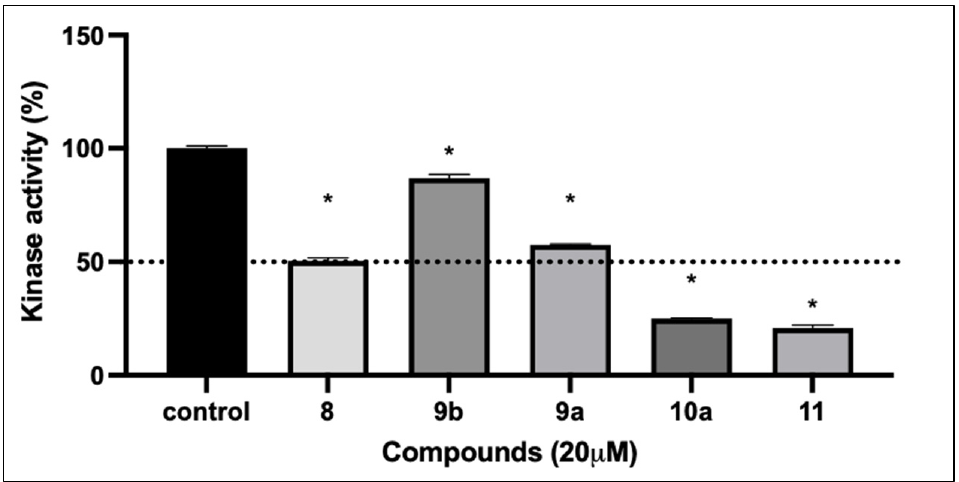
Figure 5. The effect of test compounds at 20 µ M concentration against the activity of total intracellular kinase enzymes. Data are expressed as mean ± SD; n = 3. (*): Significantly different from control group ( p value < 0.0001).